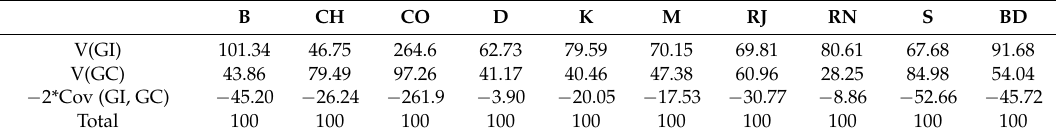
Table 10. Decomposed variance share (%) of gross income and cost of boro HYV rice, by region. B CH CO D K M RJ RN S